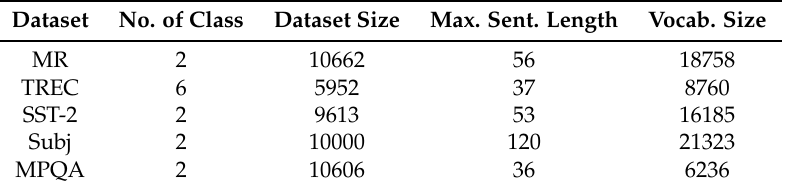
Table 1. Details of datasets used in the